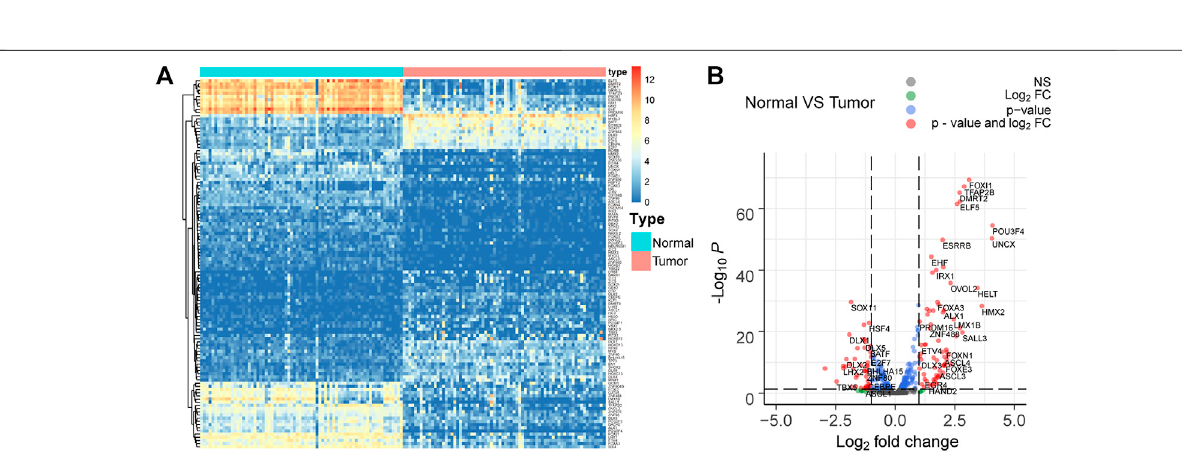
Frontiers in Molecular Biosciences |